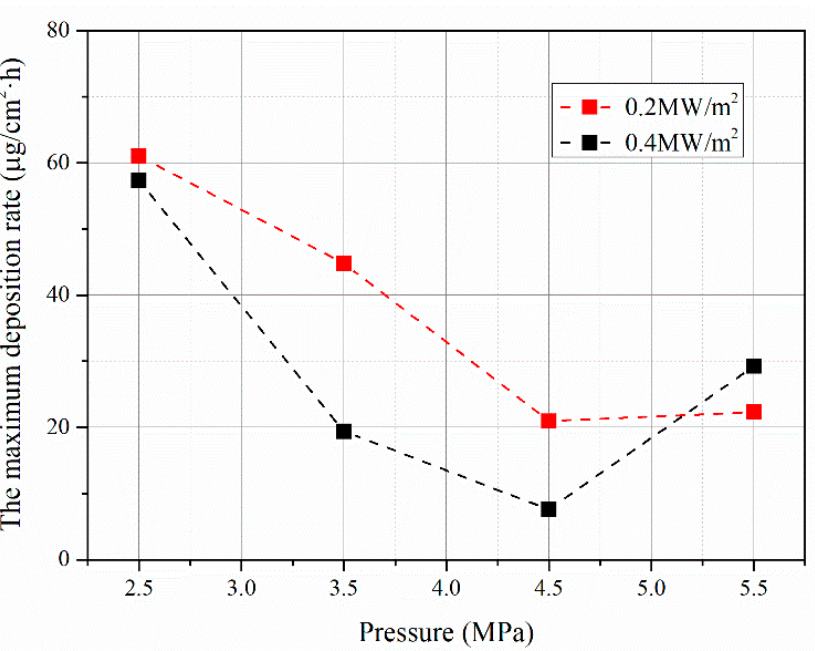
Figure 15. Variation in the maximum deposition rate with pressures under different heat fluxes. The dependence of the surface deposition rate on bulk and wall temperatures for all experiment cases is shown in Figure 16. High oxidative deposition rates were concentrated in the region with wall temperatures from 300 to 400 ◦ C, whereas pyrolytic deposition occurred only where the wall temperature was above 480 ◦ C. However, the relationship between the oxidative deposition level and bulk temperature was weaker. The bulk temperature in the high oxidative deposition region varied from 50 to 350 ◦ C, but the initial temperature of the oxidation reaction was approximately 150 ◦ C [19]. Pyrolytic deposition also occurred at a bulk temperature of 250 ◦ C, which was far from the initial temperature of the fuel pyrolysis reaction. Obviously, the dependence of surface deposition on wall temperature was stronger than its dependence on bulk temperature; this was because the formation of coking precursors and the precipitation and deposition of insoluble substances occurred in the fluid region near the